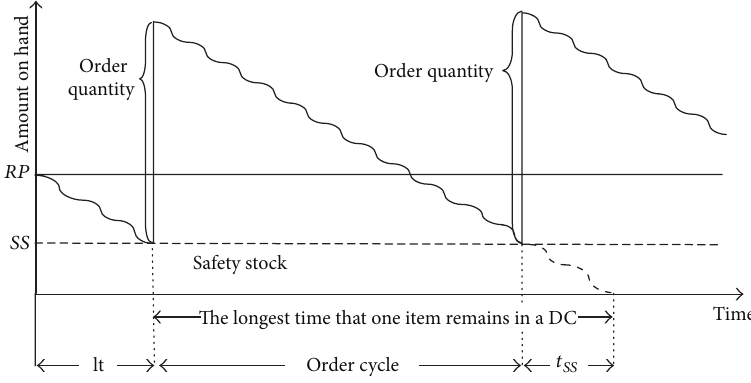
Figure 3: Profile of inventory level over time.